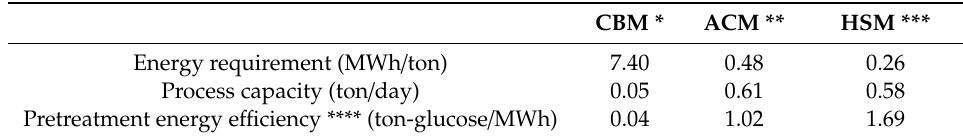
Table 2. Energy requirements, process capacities, and pretreatment energy yields for pulverizing corn stover, depending on the pulverizer